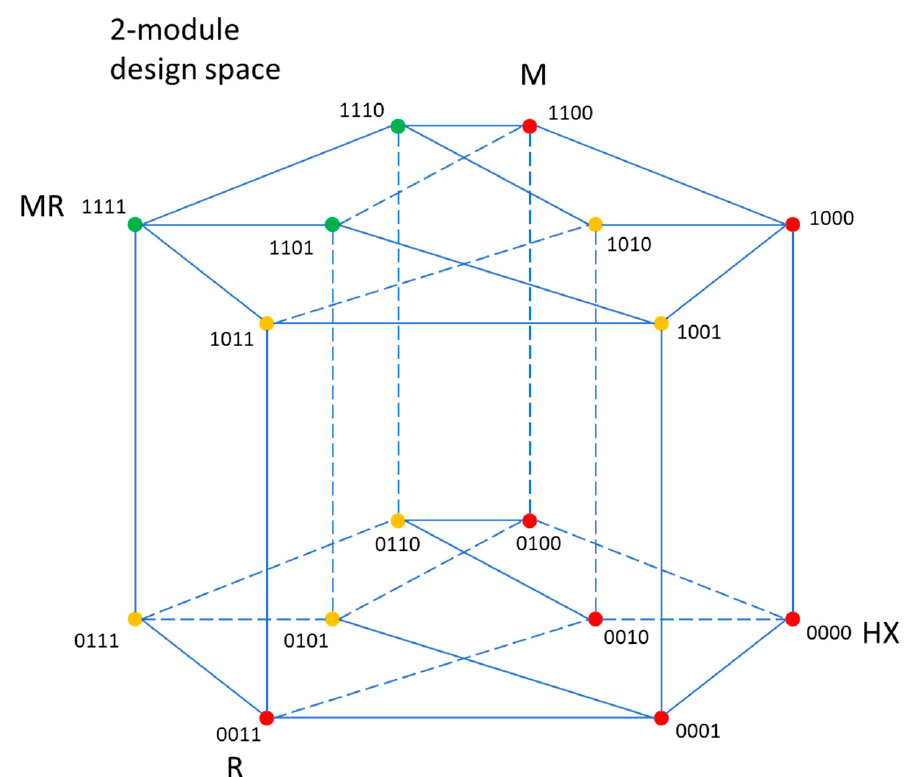
Figure 12. A graphical representation of the hypercube that defines the design space for the 2-mod problem with invalid designs (in red), valid designs with an OI of zero (in orange), and valid designs with a non-zero OI (in green). The pure heat exchanger (HX), membrane separator (M), reactor (R), and membrane reactor (MR) are labeled for reference.